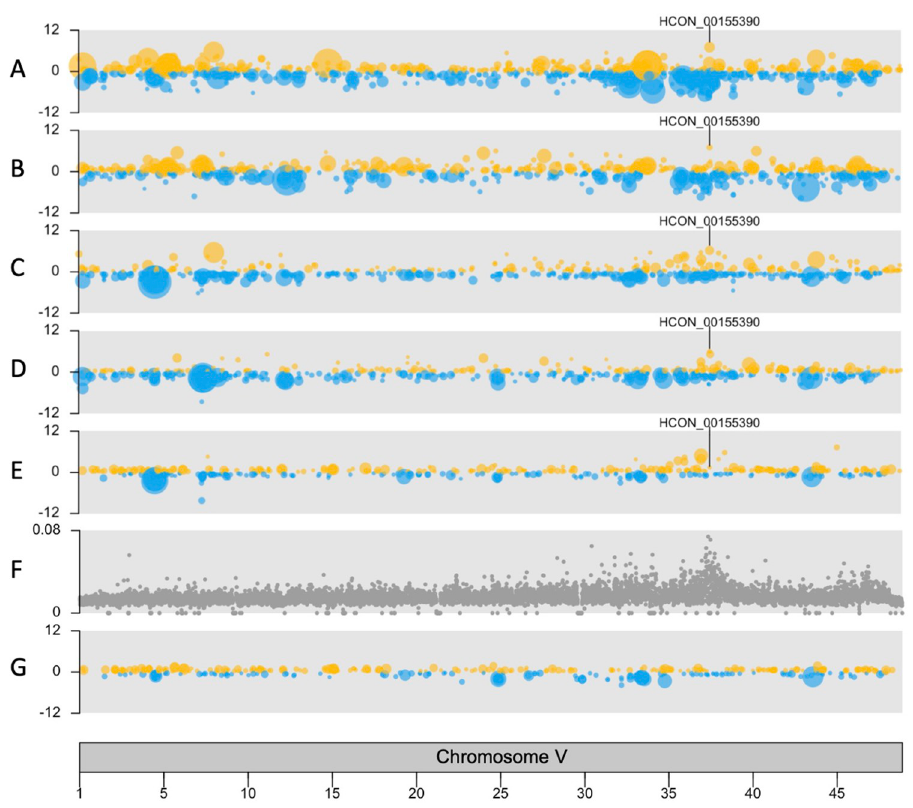
Fig 3. Chromosome V karyoplots showing genomic position of genes with significant upregulation (yellow) or downregulation (blue). Each point represents a differentially expressed gene (adj P < 0.01) and point size corresponds to significance. Panels A-D compare ivermectin-resistant versus ivermectin-susceptible populations (A. MHco18 vs MHco3 males, B. MHco18 vs MHco3 females, C. F2IVM vs MHco3 males, D. F2IVM vs MHco3 females). Panel E compares an ivermectin-resistant versus a mixed (resistant and susceptible) population (F2IVM vs F2CTL males). Panel F shows genetic differentiation ( F ST ) between the F3 generation of the genetic cross pre- and post- ivermectin selection to highlight the major locus of ivermectin selection [18]. Panel G shows relative absence of differential expression at the ivermectin QTL in a comparison with a benzimidazole selected population (F2BZ vs F2CTL males). Upregulation of the H . contortus homologue of C . elegans cky-1 (HCON_00155390) is identified in ivermectin resistant populations